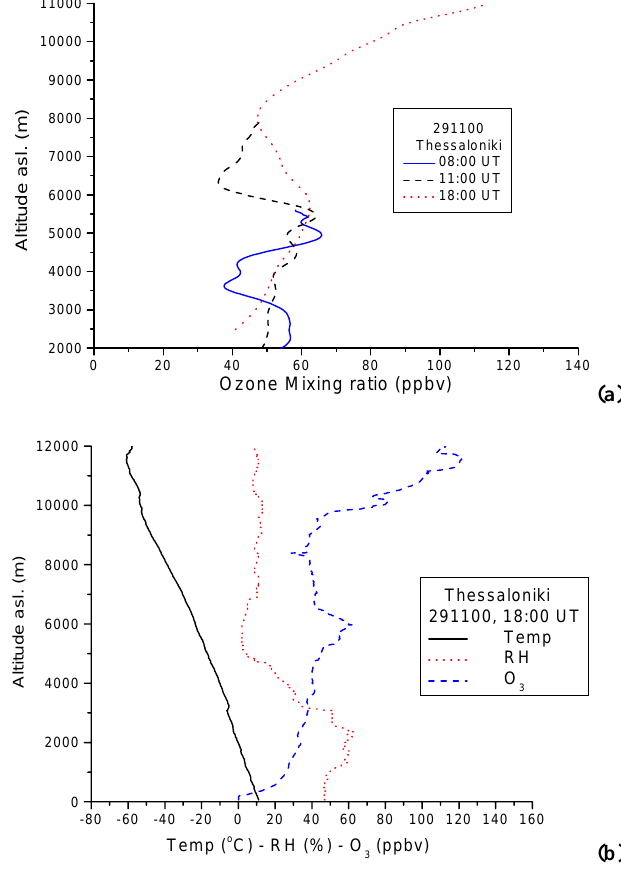
Fig. 5. (a) : Ozone DIAL vertical profiles taken over Thessaloniki, on 29 November 2000 at 08:00 UT, 11:00 UT and 18:00 UT. (b) : The vertical profile of the relative humidity (RH), O 3 and temper- ature obtained by a combined radiosonde/ozonesonde over Thessa- loniki, on 29 November 2000 at 18:00